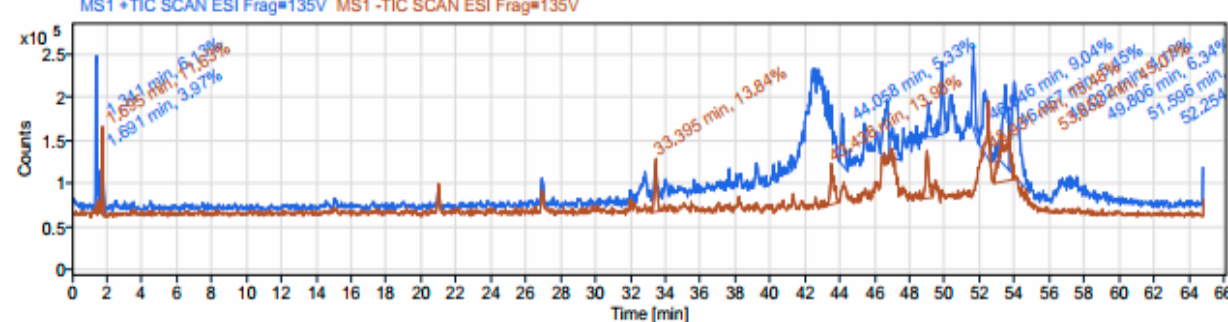
Figure 3. Total ion chromatogram of the lipids extracted from C. europaea. Table 2. Compounds identified by HPLCMSD in lipids extract of C. europaea. Peak Lipidic Compound